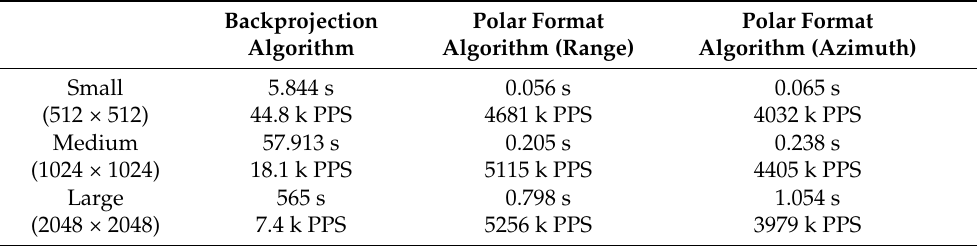
Figure 16. Images generated using the polar format algorithm with azimuth interpolation with the PERFECT dataset (sizes small, medium and large). ( a ) Perfect dataset image (size small) generated using the polar format algorithm with azimuth interpolation. ( b ) Perfect dataset image (size medium) generated using the polar format algorithm with azimuth interpolation. ( c ) Perfect dataset image (size large) generated using the polar format algorithm with azimuth interpolation. Table 6. Execution times, and the average pixels per second, of the formation of the PERFECT suite dataset image using the backprojection algorithm and the polar format algorithm with two different interpolations: range and